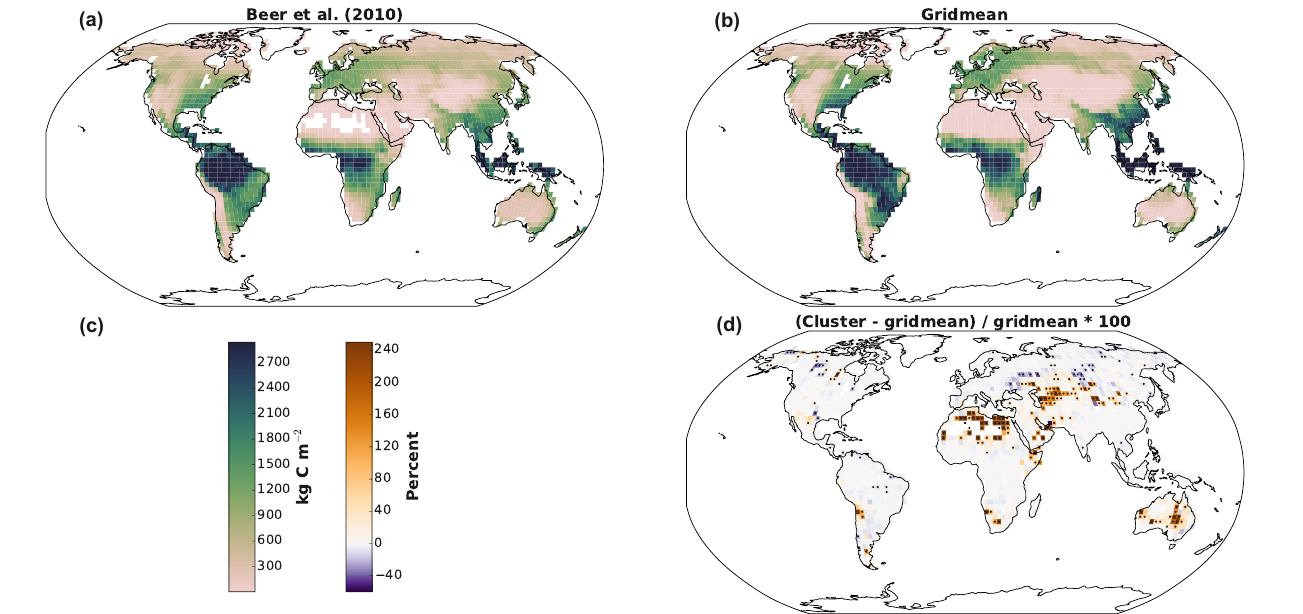
Figure 8. Mean annual gross primary productivity (1982–2008) from an observation-based dataset (Beer et al., 2010) (a) , the Gridmean simulation (b) , and percent relative difference between the Cluster and Gridmean simulations (d) . Note that many of the regions with the largest changes in GPP between the two approaches are also regions with low GPP; hence, the absolute change in GPP is generally small. Dots indicate grid cells that are statistically significant (independent two-sample t -test p level < 0 . 01). For the areas of significant change in GPP between the Cluster and Gridmean simulations, comparison of Cluster and Gridmean simulations against observations was not significant after accounting for the observational